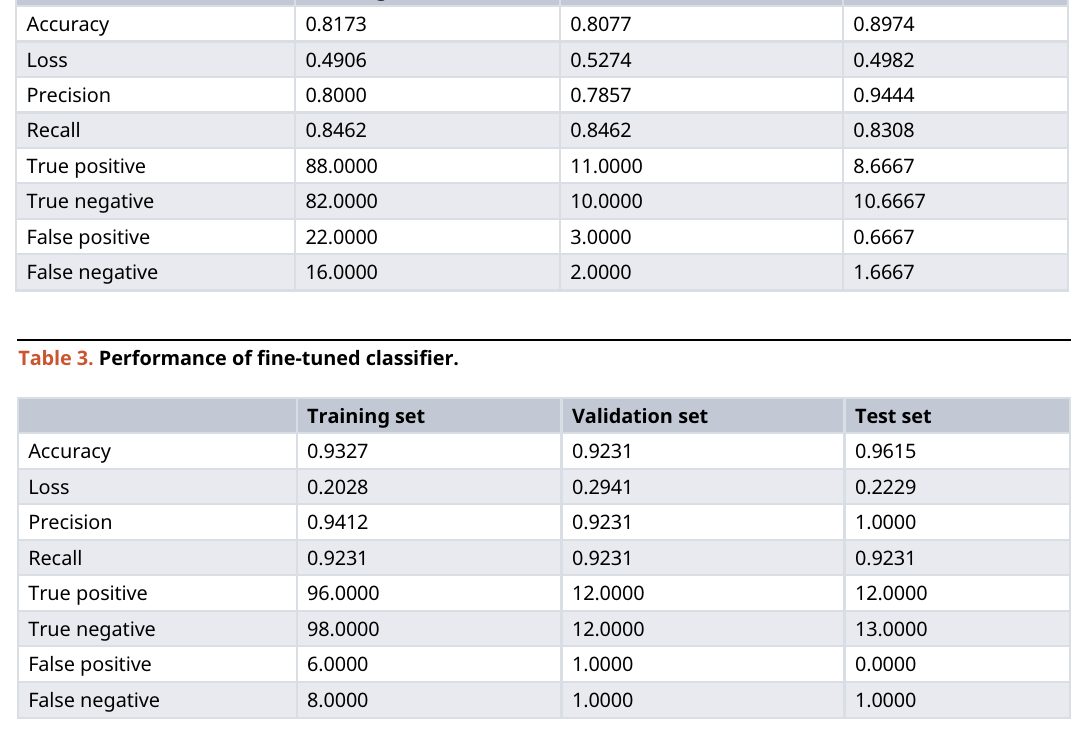
Figure 16 and Figure 17 are the samples of the binary classification results. If the prediction value is over 0.5, they are considered as healthy WBCs; otherwise, they are ALL WBCs. Results of the predicted label by the classifier and the actual label are the same. Both the sample images are classified correctly.